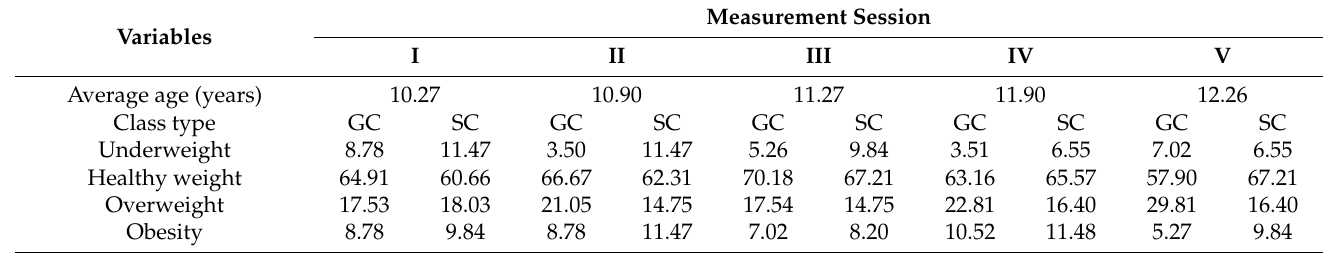
Table 2. The percentage of body mass categories in the GC and SC girls during the course of the